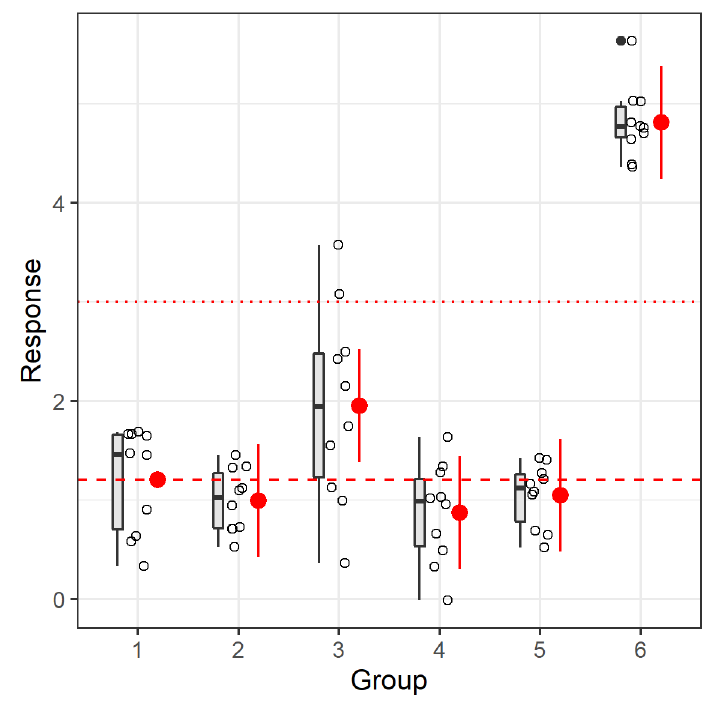
Figure 3: Simulated data plotted along with boxplots and Dunnett effect sizes. The dashed horizon- tal line shows the mean of group 1. The dotted red line could be a relevant effect